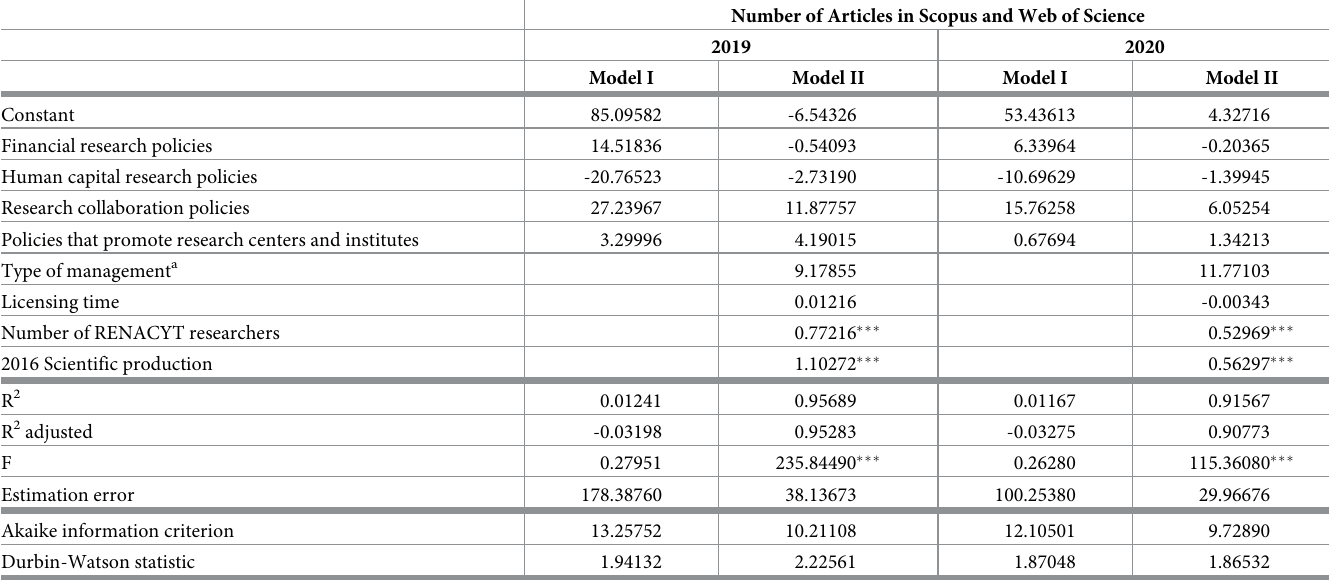
Table 5. Influence of research policies on the scientific production of the universities and graduate schools in Peru in Scopus and Web of